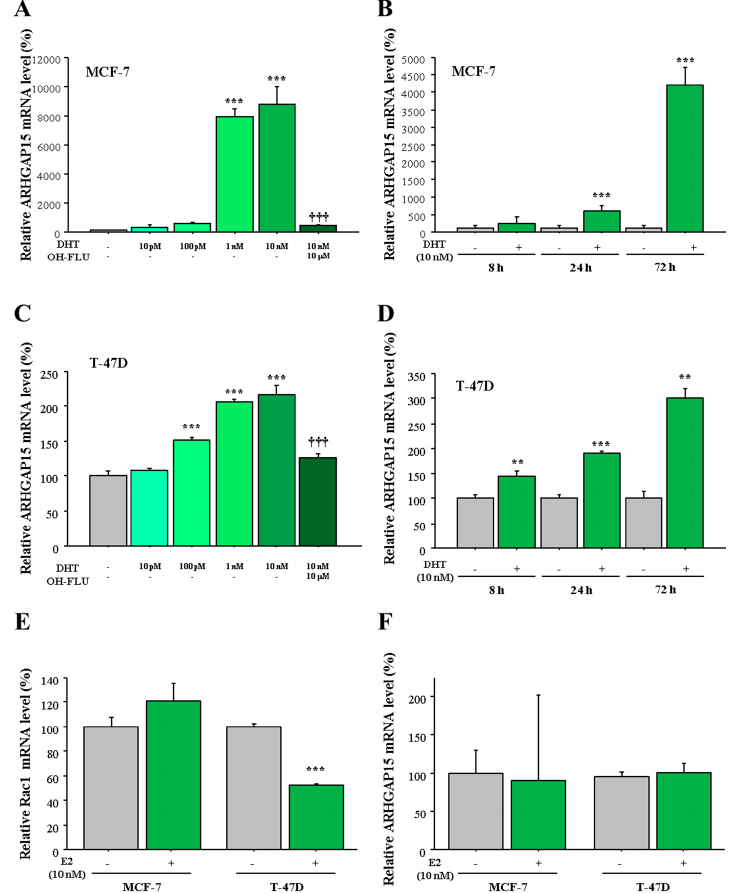
Figure 4. Regulation of ARHGAP15 mRNA by DHT in MCF-7 cells and T-47D cells. ( A , C ) MCF-7 cells ( A ) and T-47D cells ( C ) were treated with the indicated concentration of DHT for 72 h with or without hydroxyflutamide (OH-FLU), and expression of ARHGAP15 mRNA was examined using real-time PCR. ARHGAP15 mRNA was evaluated as the ratio of RPL13A mRNA and subsequently the relative ARHGAP15 mRNA level was summarized as the ratio (%) to basal level (nontreatment). ( B , D ) MCF-7cells ( B ) and T-47D cells ( D ) were treated with 10 nM DHT for indicated periods, and relative ARHGAP15 mRNA level was summarized as the ratio (%) to the basal level of each period. ( E , F ) MCF-7 and T-47D cells were treated with 10 nM estradiol (E2) for 72 h and relative Rac1 mRNA level ( E ) and ARHGAP15 mRNA level ( F ) were summarized as the ratio to basal level. Data were presented as mean ± standard deviation (SD). ** p < 0.01, *** p < 0.001 compared to basal level and ††† p < 0.001 compared to DHT-treated group (10